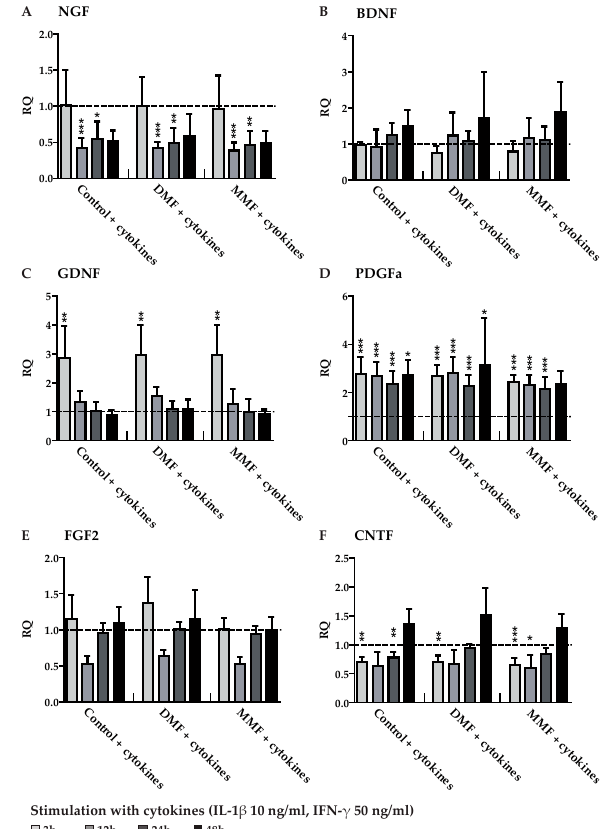
Figure 2. Gene expression of neurotrophic factors and growth factors in astrocytes pre-treated with DMF or MMF and stimulated with cytokines. Astrocytes were pre-treated with medium, 10 µM DMF or 10 µM MMF for 24 h and afterwards stimulated with cytokines (50 ng/mL interferon gamma (IFN- γ ) and 10 ng/mL interleukin 1 beta (IL-1 β )) for another 3, 12, 24 or 48 h. Graphs show mRNA expression fold changes of NGF ( A ), BDNF ( B ), GDNF ( C ), PDGFa ( D ), FGF2 ( E ), and CNTF ( F ) compared to the control group (astrocytes only treated with medium) and normalized with HPRT-1 using the ΔΔ CT method. Data are presented as the arithmetic means ± SEM of n = 3–6. Significant differences are marked by asterisks (* p < 0.05; ** p < 0.01; *** p < 0.001).